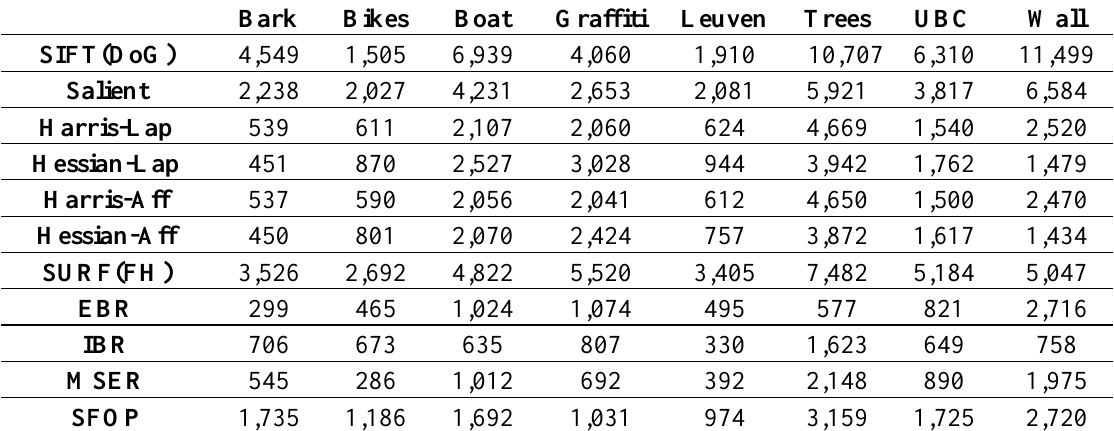
Table 7. Average number of interest points detected by feature detectors for Oxford datasets [21]. Bark Bikes Boat